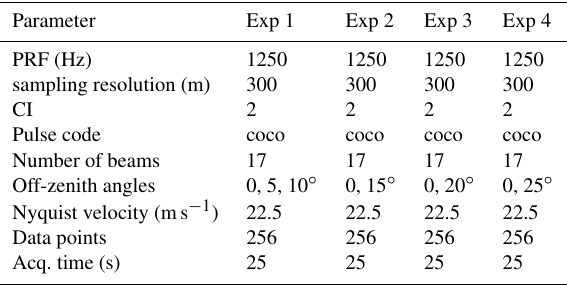
Figure 1. Projection of MAARSY beam positions for the multi- beam experiments during summer 2013. The red circles show the il- luminated radar beam area assuming a beam width of 3.6 ◦ at 84km altitude. The black lines are the shoreline around the North Norwe- gian island Andøya. Table 1. Experiment parameters (PRF: pulse repetition frequency; CI: coherent integrations; acq: acquisition; pulse code: coco – 16 bit complementary code).